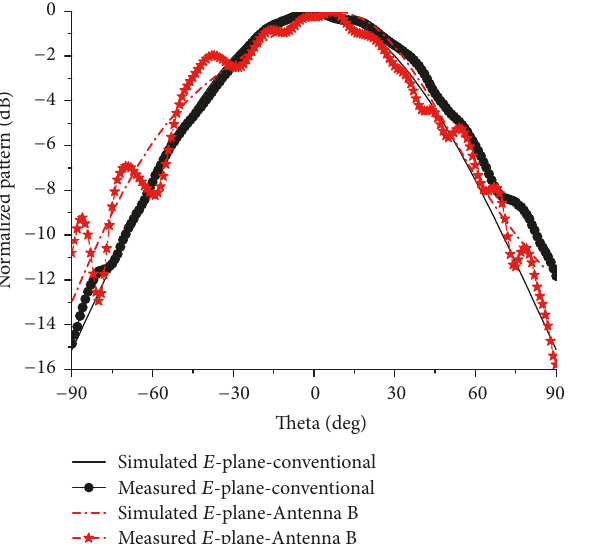
Figure 9: Comparisons of 𝐸 -plane patterns for the conventional antenna and Antenna B.